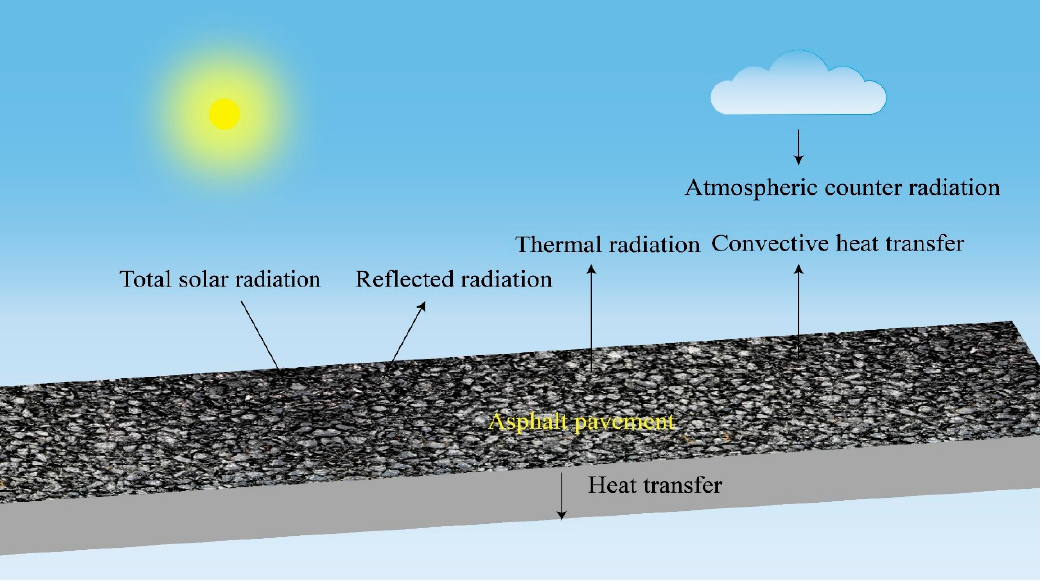
Figure 1. Thermal environment of asphalt pavement.